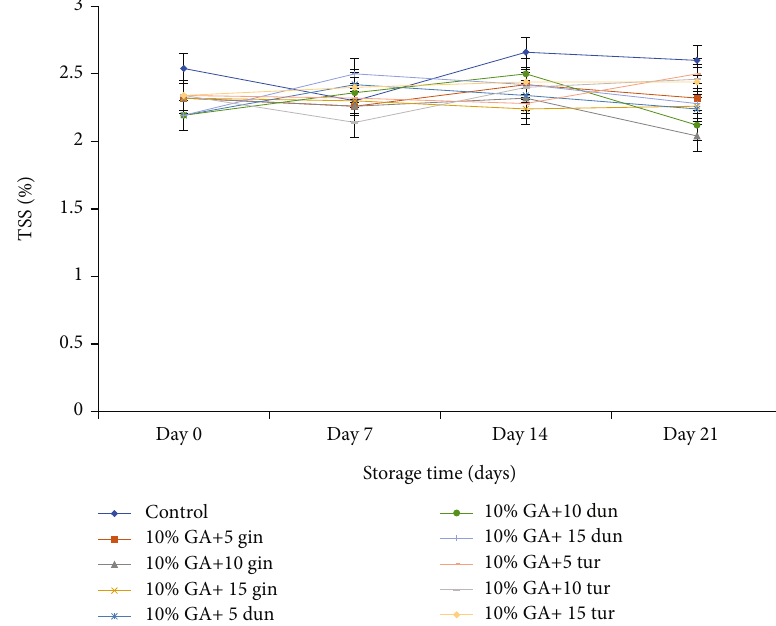
Figure 9: E ff ect of 10% GA incorporated with plant extracts at di ff erent concentrations on TSS during cold storage for 21